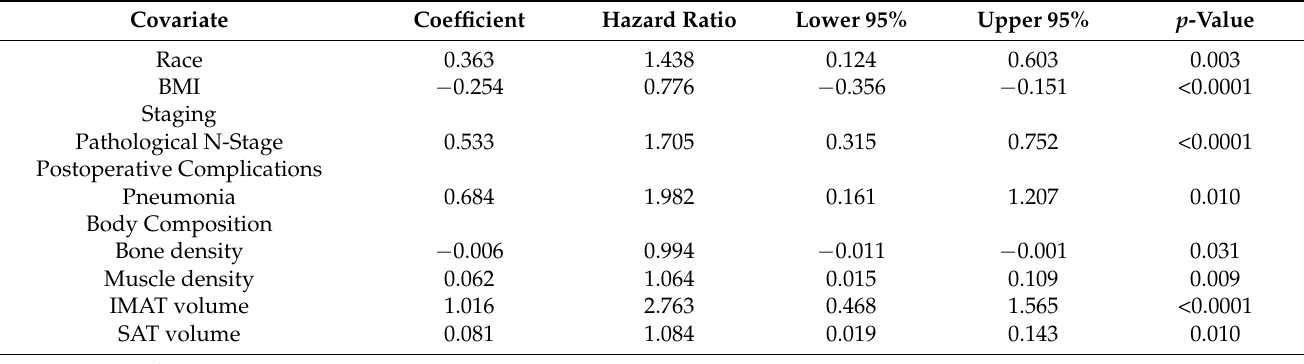
Table 4. Multivariate Cox proportional-hazard model for survival post-esophagectomy (n =